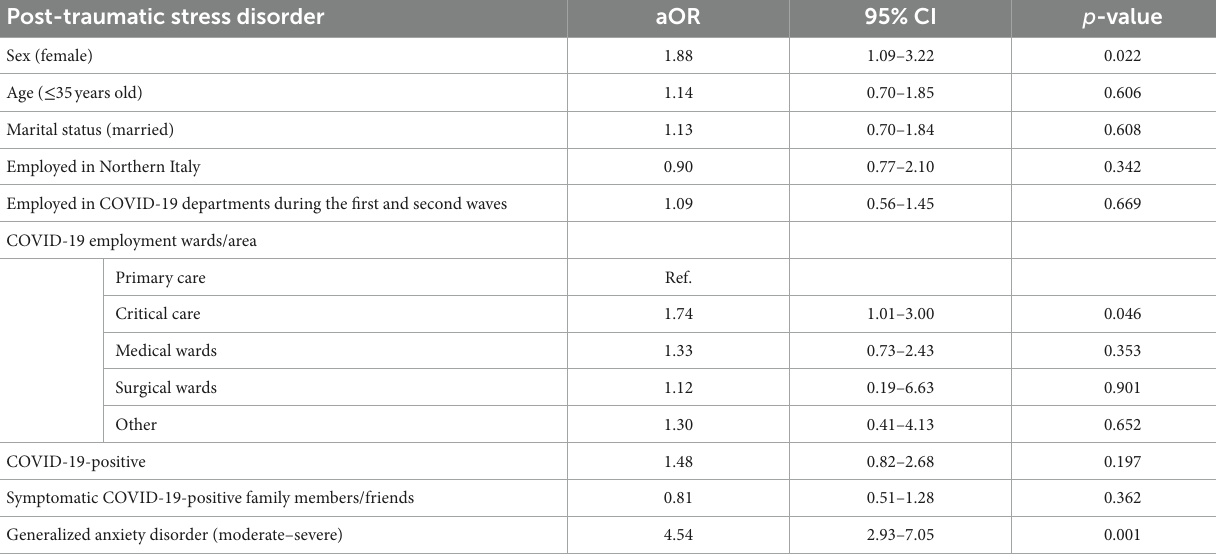
TABLE 6 Factors associated with post-traumatic stress disorder (IES-R ≥ 33) in nurses. Post-traumatic stress